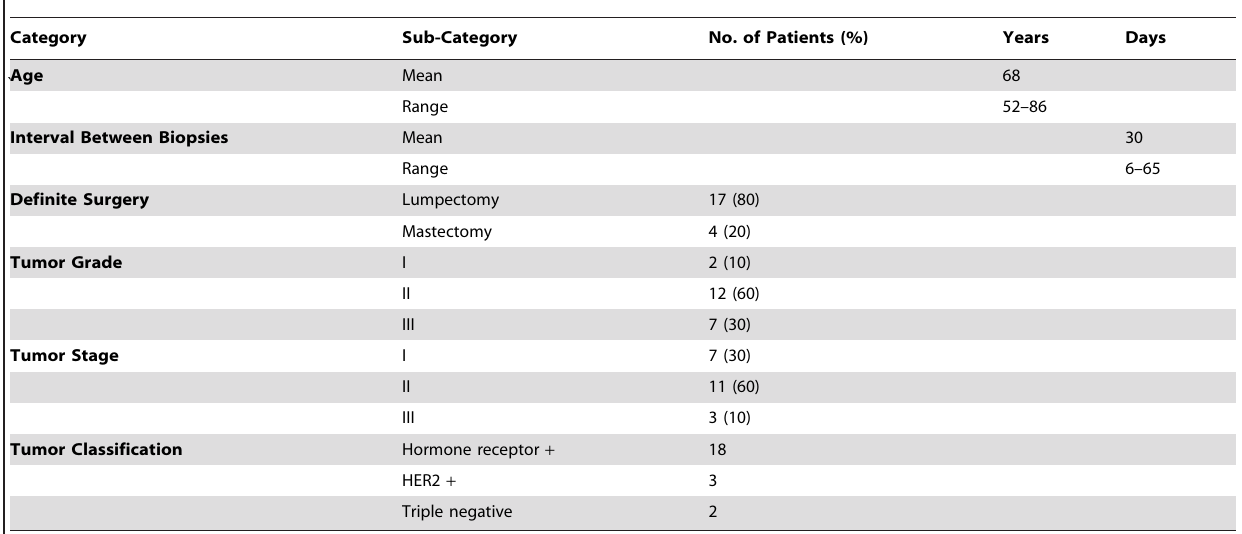
Table 1. Clinical characteristics of the participating patients.